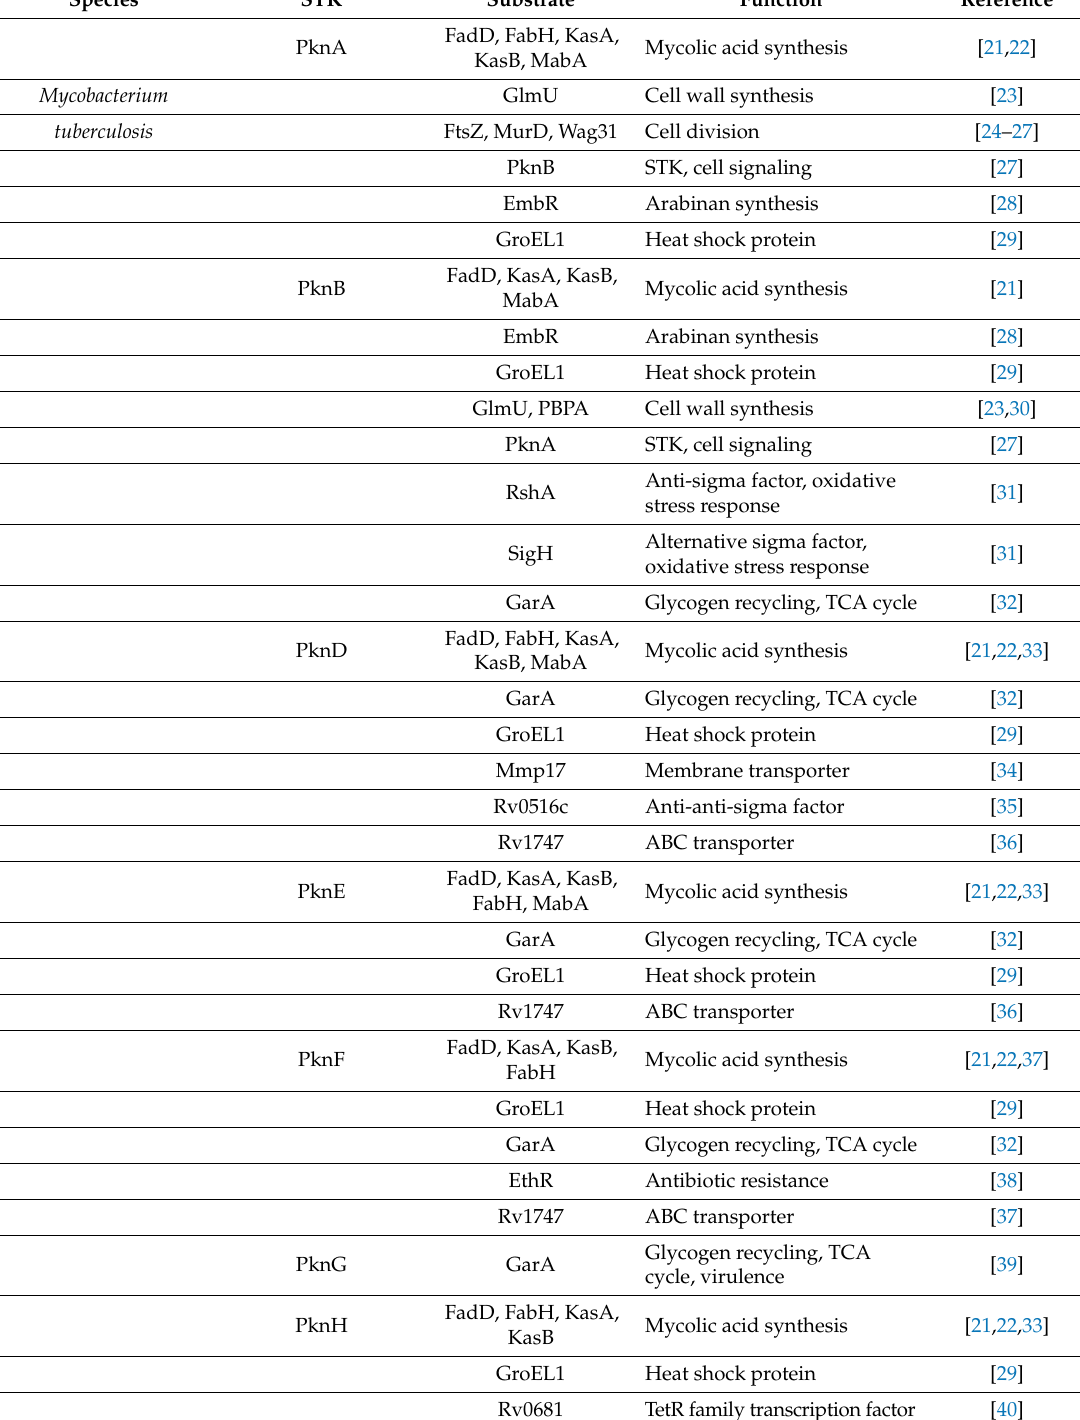
Table 1. Serine/threonine kinases (STKs) of Gram-positive and Gram-negative bacteria, their substrates, and biological